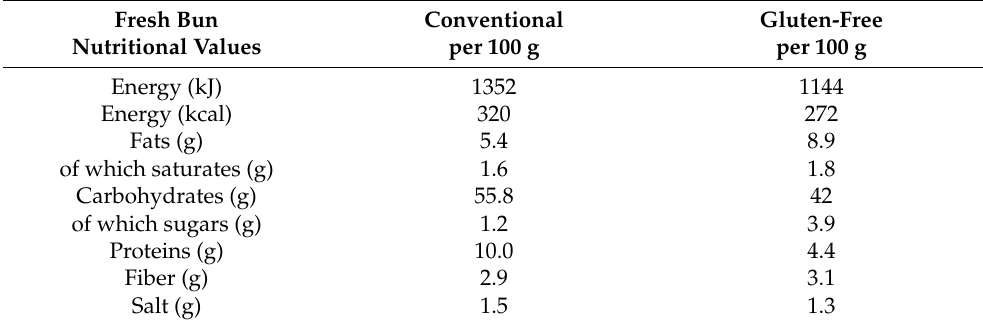
Table 2. Nutritional values of wheat buns and gluten-free buns. These values were obtained from the product packages or available on https://itesco.cz/ (accessed on 24 January 2022). Fresh Bun Conventional Gluten-Free Nutritional Values per 100 g per 100 g Energy (kJ) 1352 1144 Energy (kcal) 320 272 Fats (g) 5.4 8.9 of which saturates (g) 1.6 1.8 Carbohydrates (g) 55.8 of which sugars